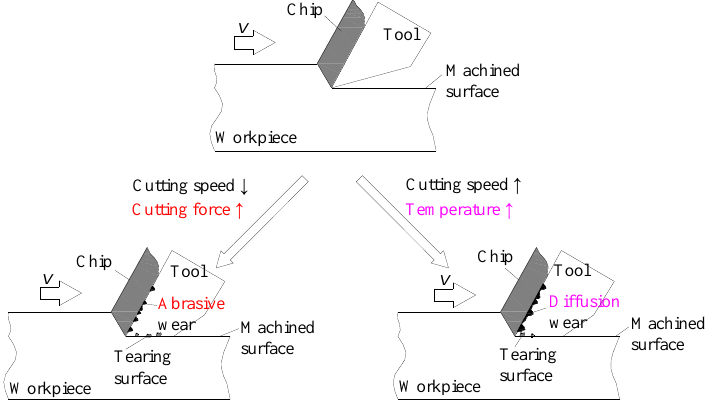
Figure 1. The schematic diagram of tool wear and surface defects in pure copper milling.